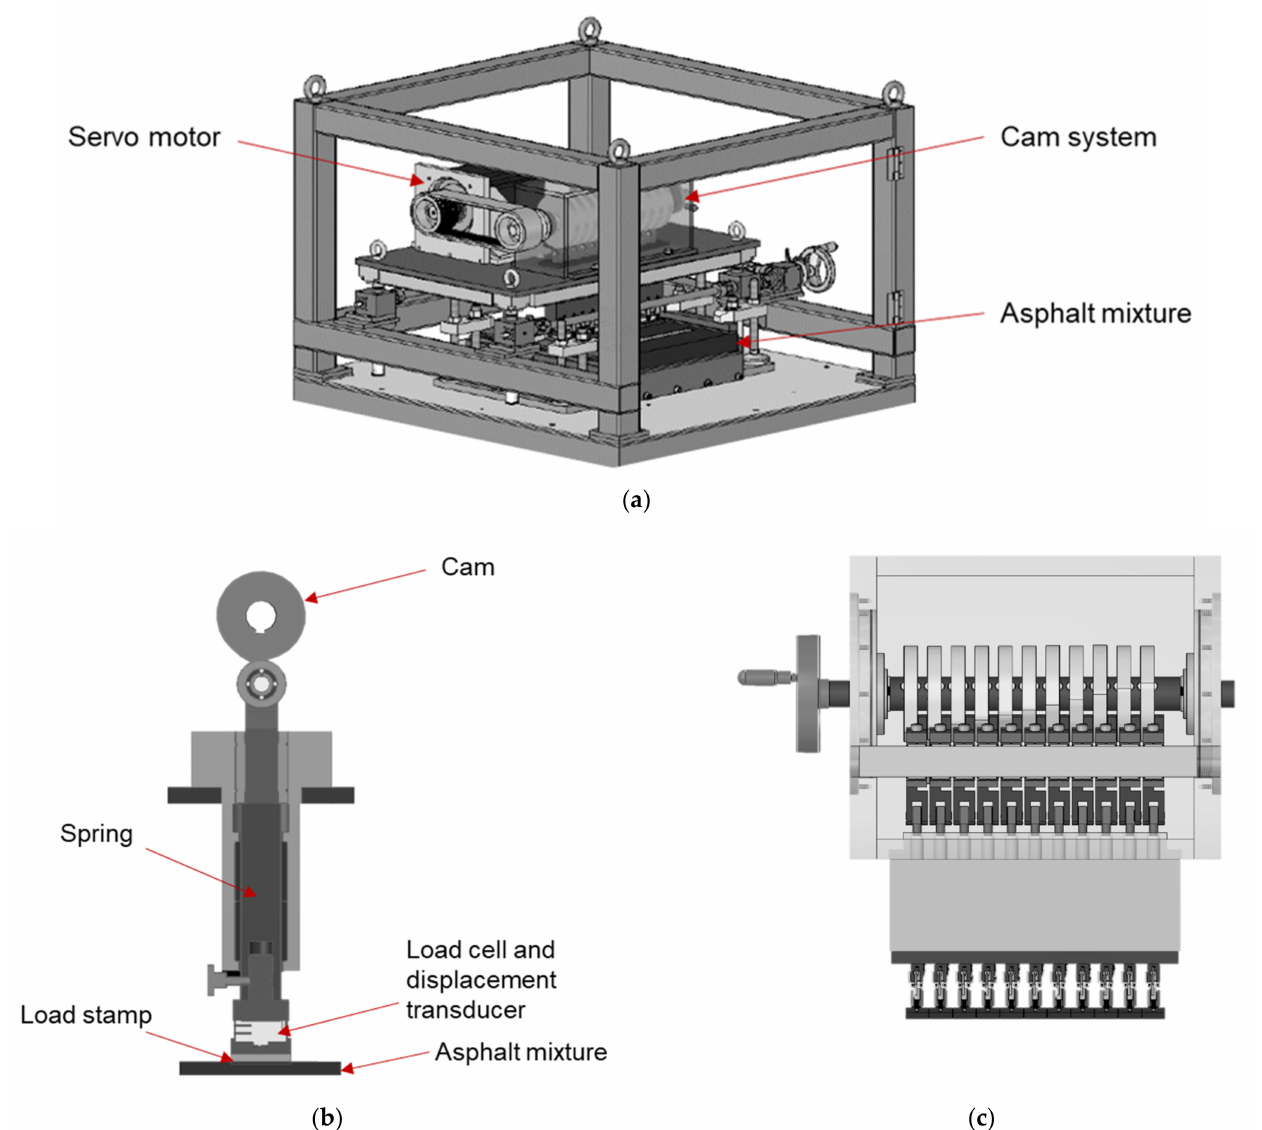
Figure 14. Details on the ARROWS. ( a ) Schematic diagram of ARROWS. ( b ) Side view of a loading unit. ( c ) Front view of the loading